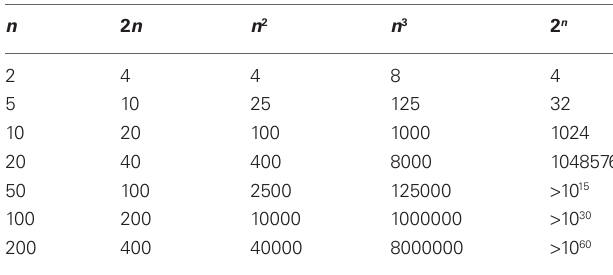
Table A3 | illustration of how polynomial growth rates ( n , 2 n , n 2 , n 3 ) compare with an exponential growth rate (2 n